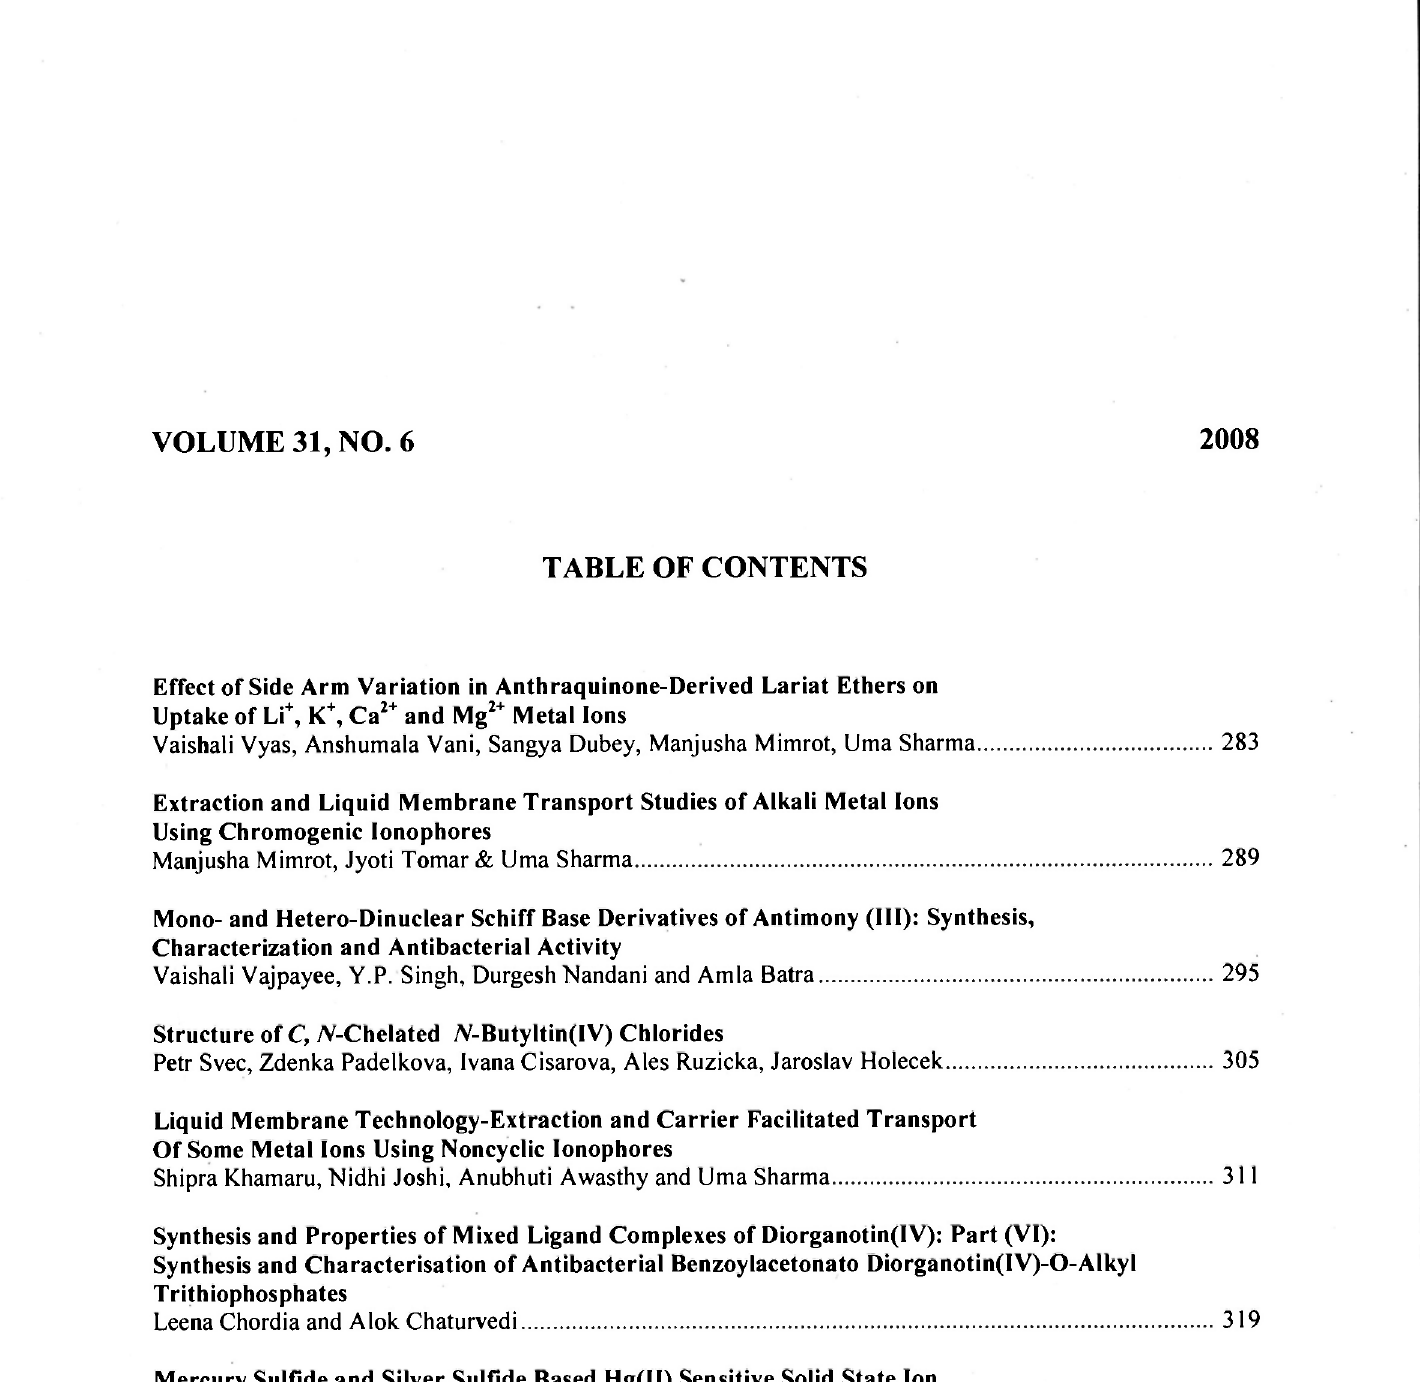
Effect of Side Arm Variation in Anthraquinone-Derived Lariat Ethers on Uptake of Li + , K + , Ca 2+ and Mg 2+ Metal Ions